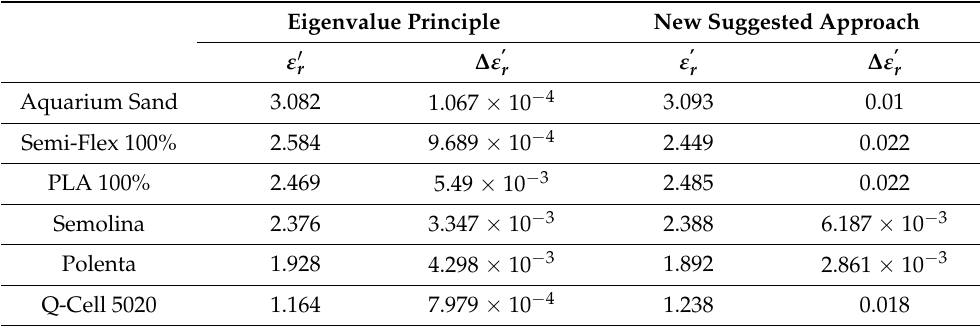
Table 2. Comparison of the medium’s relative permittivity ε (cid:48) r and its uncertainty ∆ ε (cid:48) r from the filled two-lines technique.